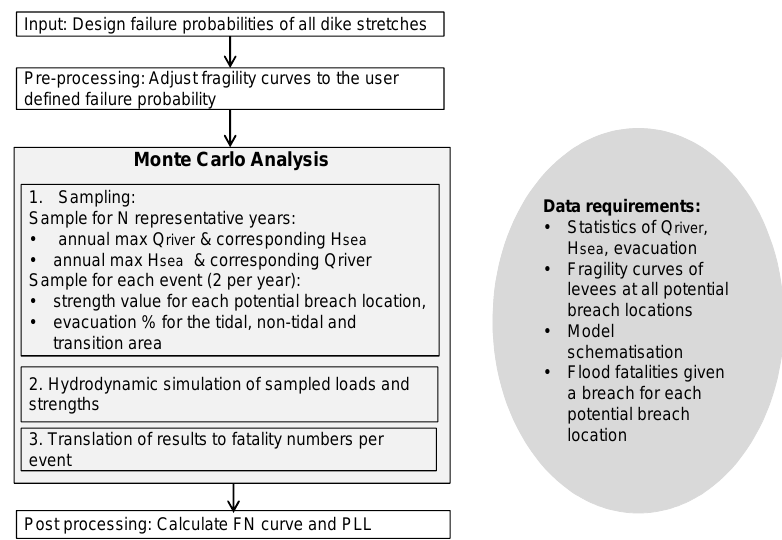
Figure 1. Schematic overview of the probabilistic risk assessment method for river deltas.